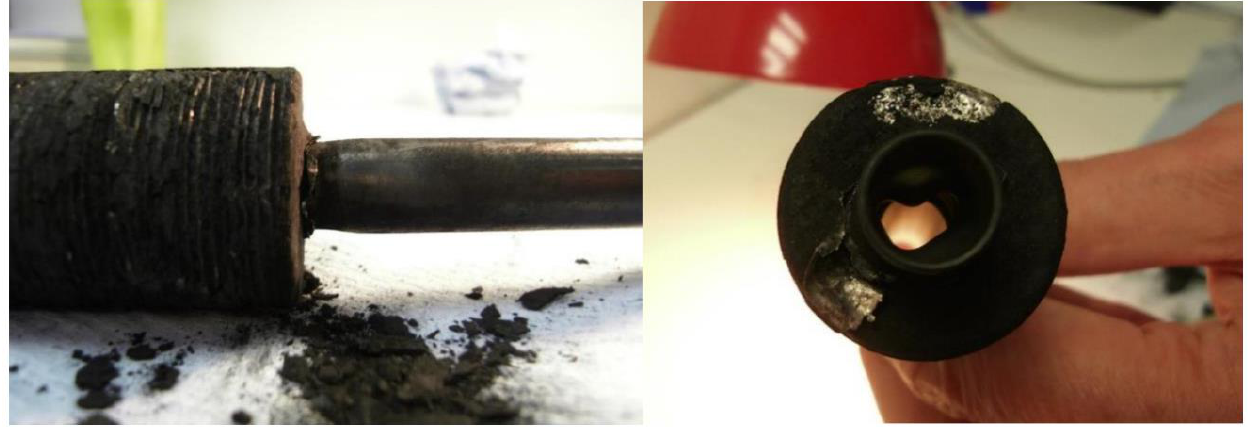
Figure 4. Preliminary trials with cylindrical modules caused crushing of the central tube.